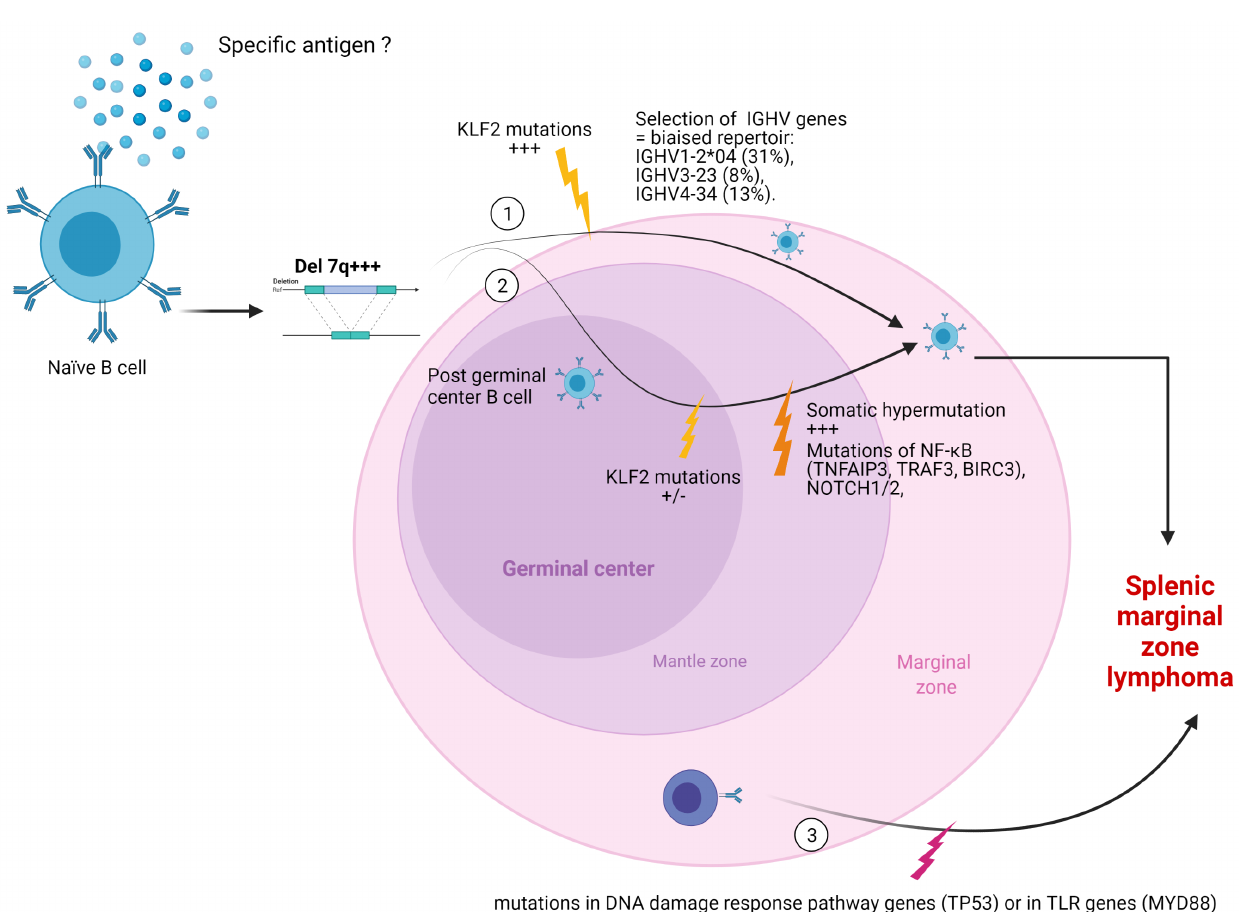
Figure 4. The top of the figure illustrates the two firsts pathways arising from a naïve B-cell and characterized by a deletion of the long arm of chromosome 7. Pathway n ◦ 1 is supposed not to pass through the germinal center. SMZL developed from this pathway presents a repertory bias with a preferential use of IGHV1-2*04 and is supposed not to undergo somatic hypermutation. Pathway n ◦ 2 is supposed to pass through the germinal center where somatic hypermutation happens, and mutations involving the non-canonical NF κ B pathway and NOTCH1/2 are added (sometimes associated with KLF2 mutations). The third pathway is characterized by mutations of DNA repair genes ( TP53 ) or TLRs genes ( MYD88 ). More studies are required to precisely define these pathways and correlate them with histological patterns, immunohistochemistry, and clinical data (particularly prognosis). Created with BioRender.com. Abbreviations: BIRC3 , baculoviral IAP repeat- containing protein 3; IGVH, immunoglobulin G heavy chain; KLF2 , Krüppel-like factor 2; MYD88 , myeloid differentiation primary response 88; NOTCH , neurogenic locus notch homolog protein; TNFAIP3 , tumor necrosis factor alpha-induced protein 3; TP53 , tumor protein P53; TRAF3 , tumor necrosis factor receptor-associated factor